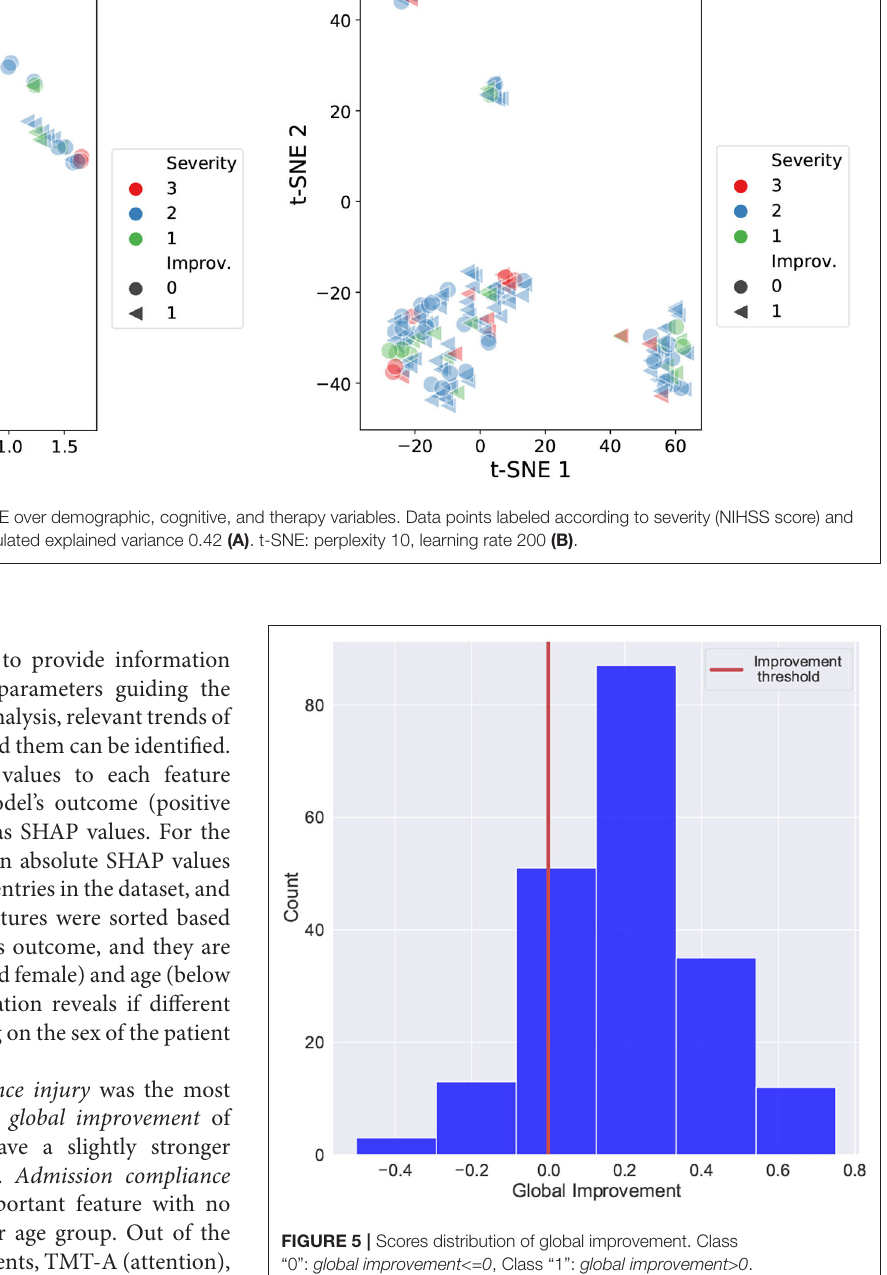
effect across sex and age, orientation task proportion was the only variable showing a clear difference over these